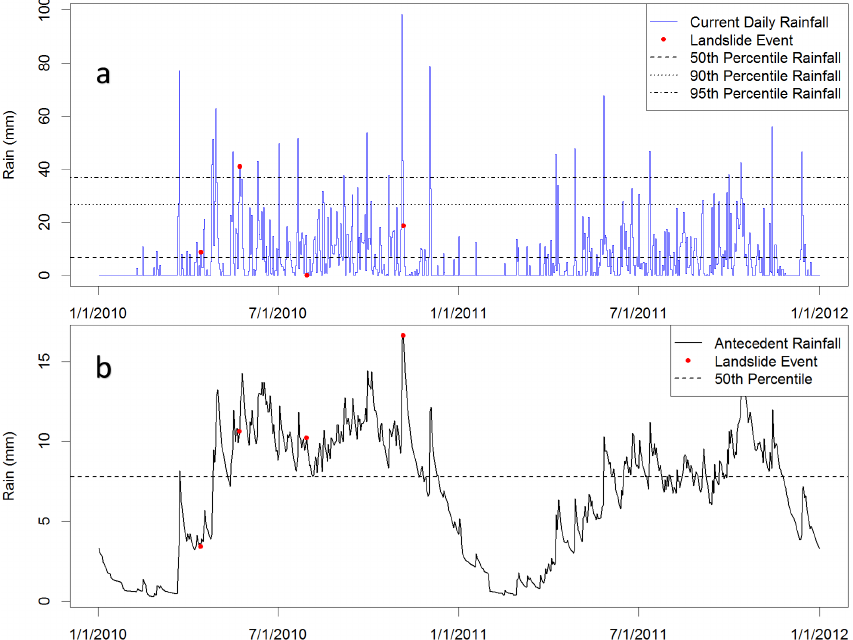
Figure 7. Example time series of (a) rainfall and (b) antecedent rainfall for a pixel west of San Jose, Costa Rica. The time series highlight four landslides that were reported in this area in 2010: 14 April, 22 May, 30 July and 5 November (shown as red circles). The first landslide (Fig. 9a) occurred very early in the year before the peak rainy season and a nowcast was not issued. The time series shown in the upper graph indicates that a moderate-hazard nowcast was triggered for the 5 November event and a high-hazard nowcast was triggered for the 22 May event (Fig. 9b). However, due to the antecedent rainfall for the 14 April event and low rainfall totals for the 30 July event, no nowcasts were